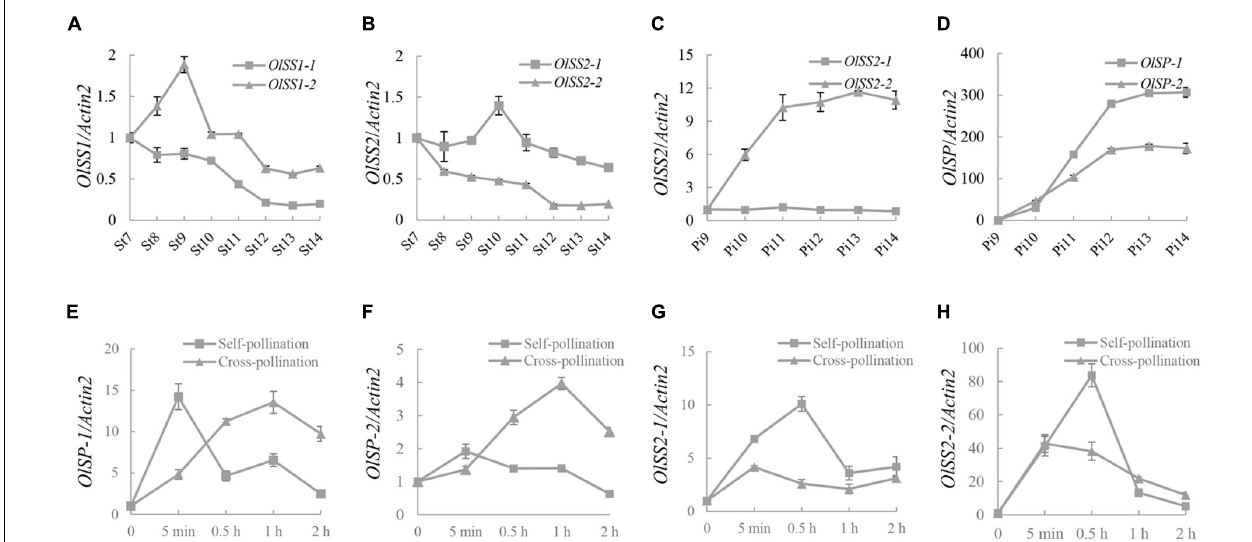
FIGURE 5 | The expression pattern of OlSSs and OlSP . (A) Expression profile of OlSS1 from stage 7 to stage 14 in stamens. OlSS1-1 was down-regulated at all stamen developmental stages, whereas OlSS1-2 was up-regulated at stages 7–9, and gradually down-regulated from stages 9 to 14. (B) The expression pattern of OlSS2 from stage 7 to 14 in stamens. The down-related expression of OlSS2-1 commenced at stage 10. (C) The expression pattern of OlSS2 in pistils. OlSS2-2 up-regulated during pistil development, whereas we detected no significant changes in the expression of OlSS2-1 . (D) The expression profile of OlSP in pistils. OlSP-1 and OlSP-2 were up-regulated in pistils. (E) The expression profile of OlSP-1 in pistils after self-/cross-pollination. The down-regulated expression of OlSP-1 commenced 5 min after self-pollination, and reached the highest level at 1 h after cross-pollination. (F) The expression profile of OlSP-2 in pistils after self-/cross-pollination. OlSP-2 showed significant changes in expression following self-pollination, but was up-regulated after cross-pollination, attaining the highest level after 1 h. (G) The expression profile of OlSS2-1 in pistils after self-/cross-pollination. OlSS2-1 was up-regulated within 0.5 h of self-pollination, after which the levels of expression began to decline. In contrast, no significant changes were detected in the expression of OlSS2-1 following cross-pollination. (H) The expression profile of OlSS2-2 in pistils after self-/cross-pollination. OlSS2-2 was up-regulated within 0.5 h of self-pollination, and subsequently down-regulated. Following cross-pollination, the highest level of OlSS2-2 expression was detected within 5 min, after which expression was down-regulated. St, stamen; Pi, pistil; St7 to St14, pollen development from stages 7 to 14; Pi9 to Pi14, pistil development from stages 9 to